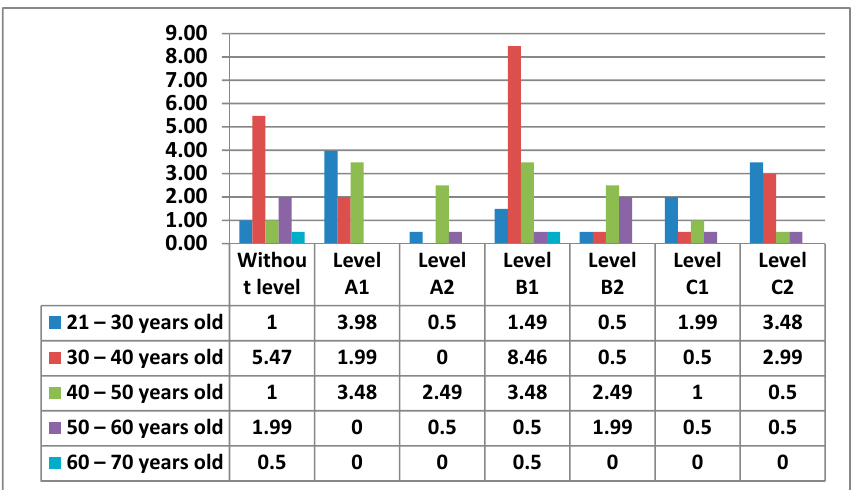
Figure 25. Digital competence in men by age in Area 4. Int. J. Environ. Res. Public Health 2020 , 17 , x